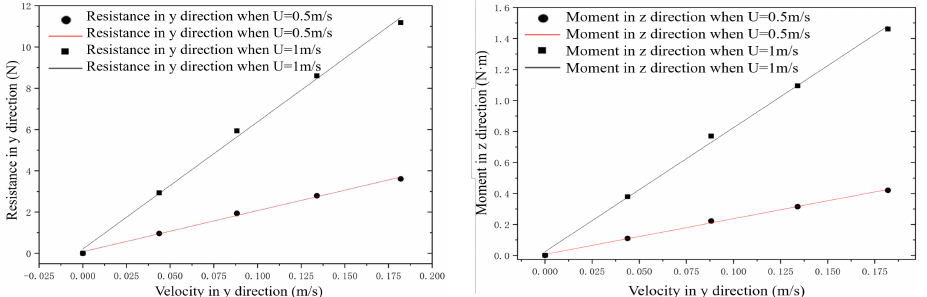
Figure 9. Left diagram shows the relationship of lateral resistance Y versus lateral velocity v ; the right diagram shows the relationship of roll moments N versus lateral velocity v